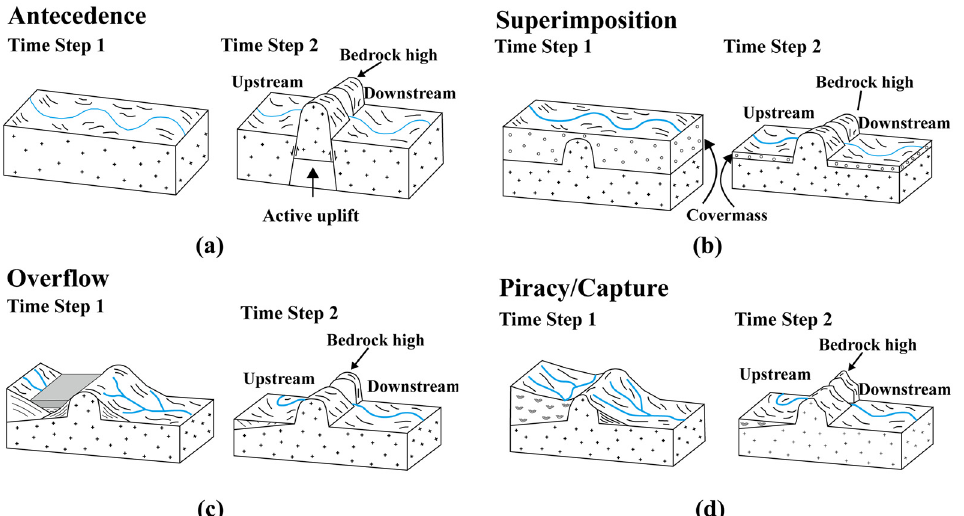
Figure 1. Basic descriptions of the formation of the transverse canyon by four mechanisms. ( a ) An- tecedence: prior to orogeny, streams existed and were penetrated by mountains that were rising; ( b )